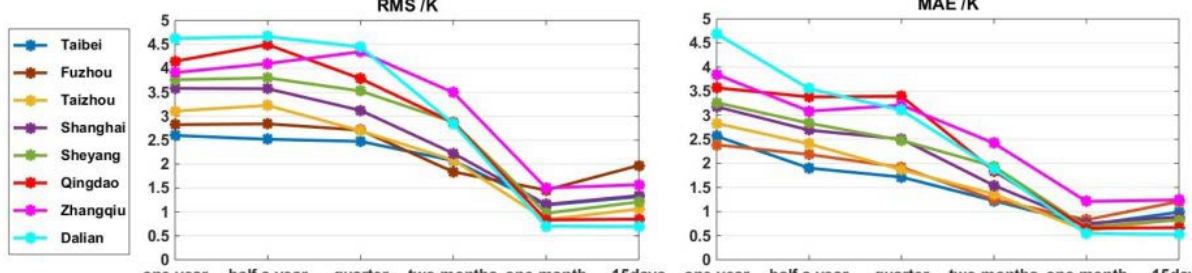
Fig 4. Spatio-temporal adaptability analysis of RFF-Tm